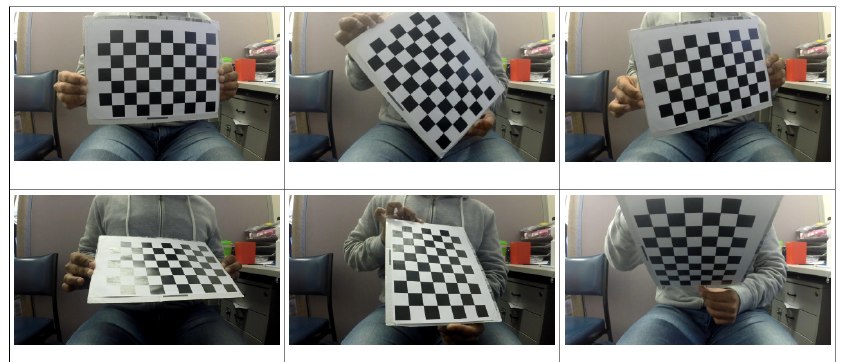
Figure 11. Representative images of the checkerboard pattern used for camera